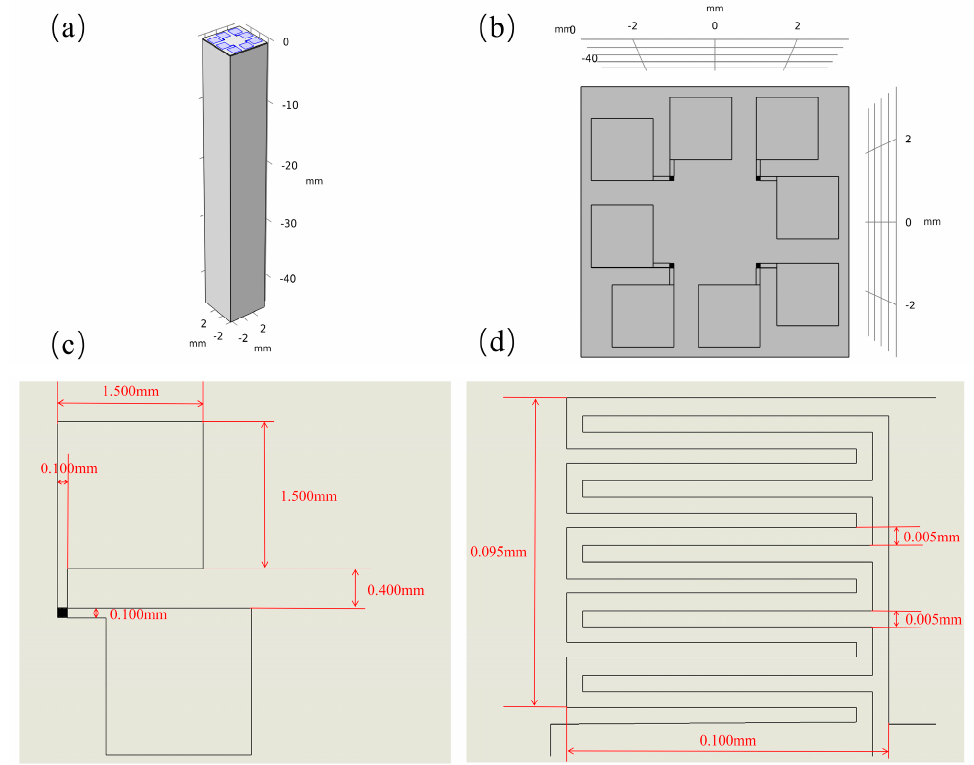
Figure 9. Geometric dimensions of finite element model. ( a ) 3D modeling diagram; ( b ) top view of the 3D modeling drawing; ( c ) geometric dimensioning of the electrode wiring section; ( d ) dimensioning of a thermal sensing unit.